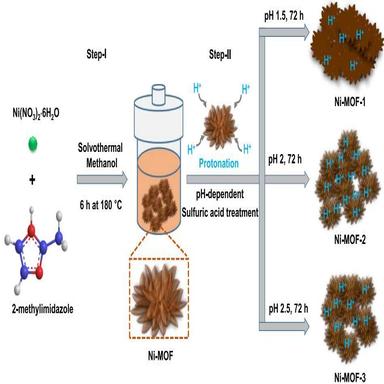
(a) XRD patterns of Ni-MOF, Ni-MOF-1, Ni-MOF-2, and Ni-MOF-3 samples (b) FT-IR spectra of Ni-MOF, Ni-MOF-1, Ni-MOF-2, and Ni-MOF-3 samples (inset shows the magnified portion of eOH stretching vibrations), (c) TGA analysis curve of Ni-MOF and Ni-MOF-2, (d) N2 adsorption-desorption isotherms of Ni-MOF, Ni-MOF-1, Ni-MOF-2, and Ni-MOF-3 samples, (e) pore size distribution of Ni-MOF, Ni-MOF-1, Ni-MOF-2, and Ni-MOF-3 samples, and (fei) High-resolution XPS spectra of Ni 2p, C 1s, N 1s, and O 1s regions for Ni-MOF